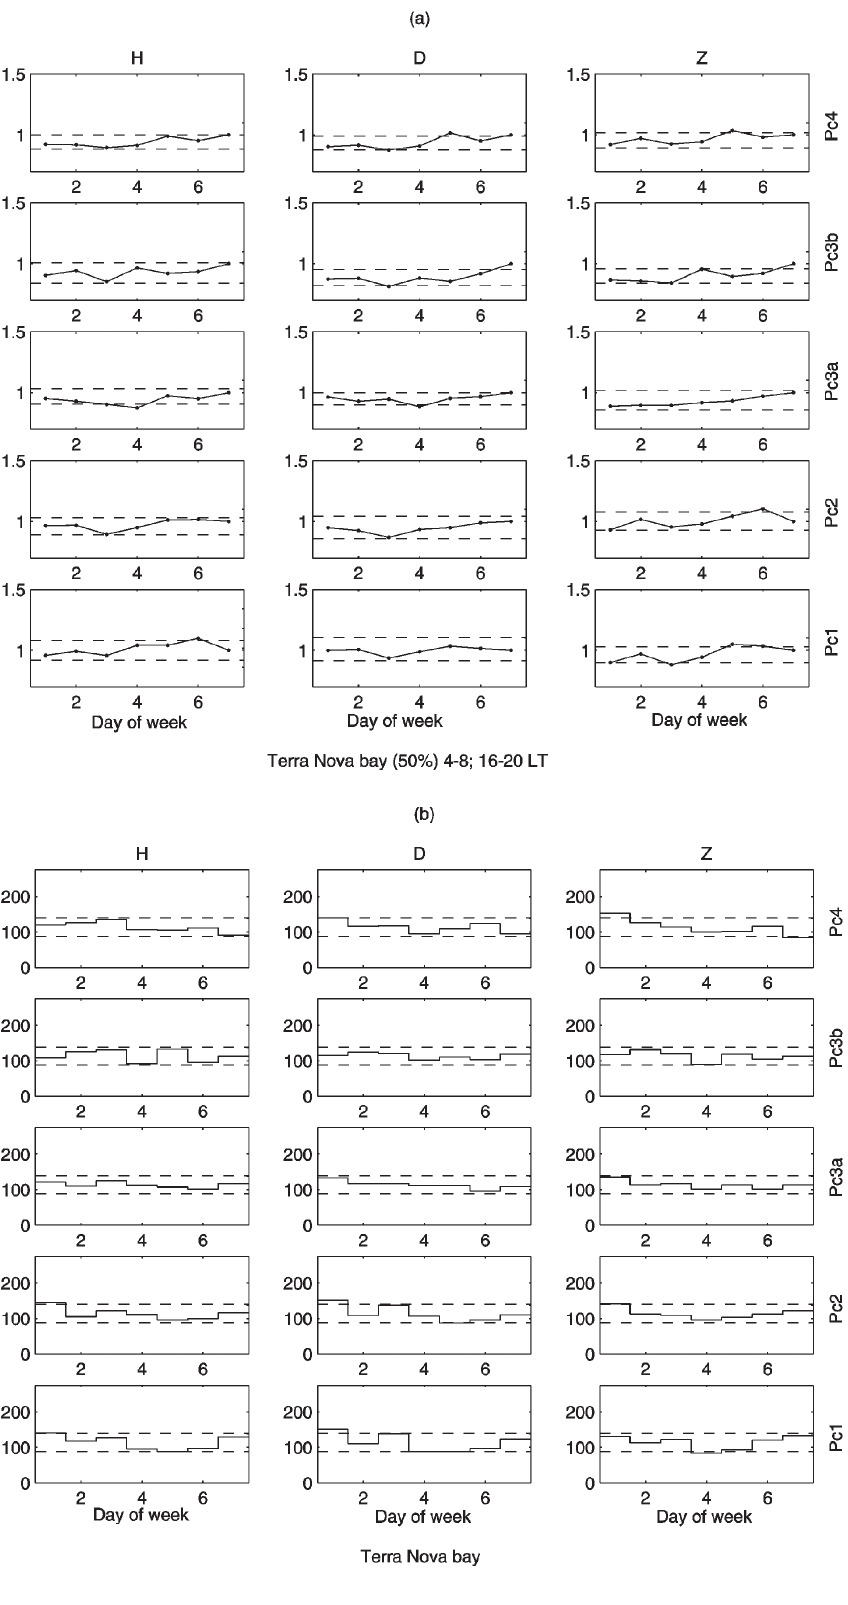
Fig. 7. (a) Weekly variation of the average power of magnetic field components in different frequency bands at Terra Nova Bay (Antarctica, 50% of original spectra). Dashed lines identify the 99% confidence interval. (b) Weekly distribution of the lowest values of power (5% of the whole population) in different frequency bands at Terra Nova Bay (Antarctica). Dashed lines identify the 99% confidence